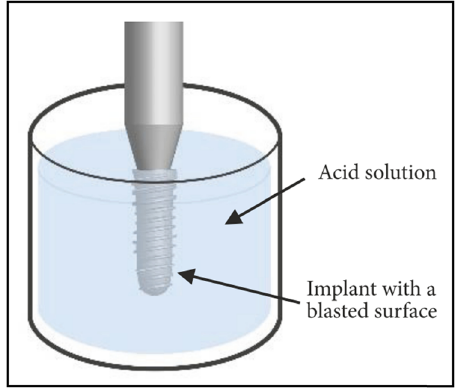
Figure 2: Schematic illustration of the AE process [ 49 ] . Copyright 2014,